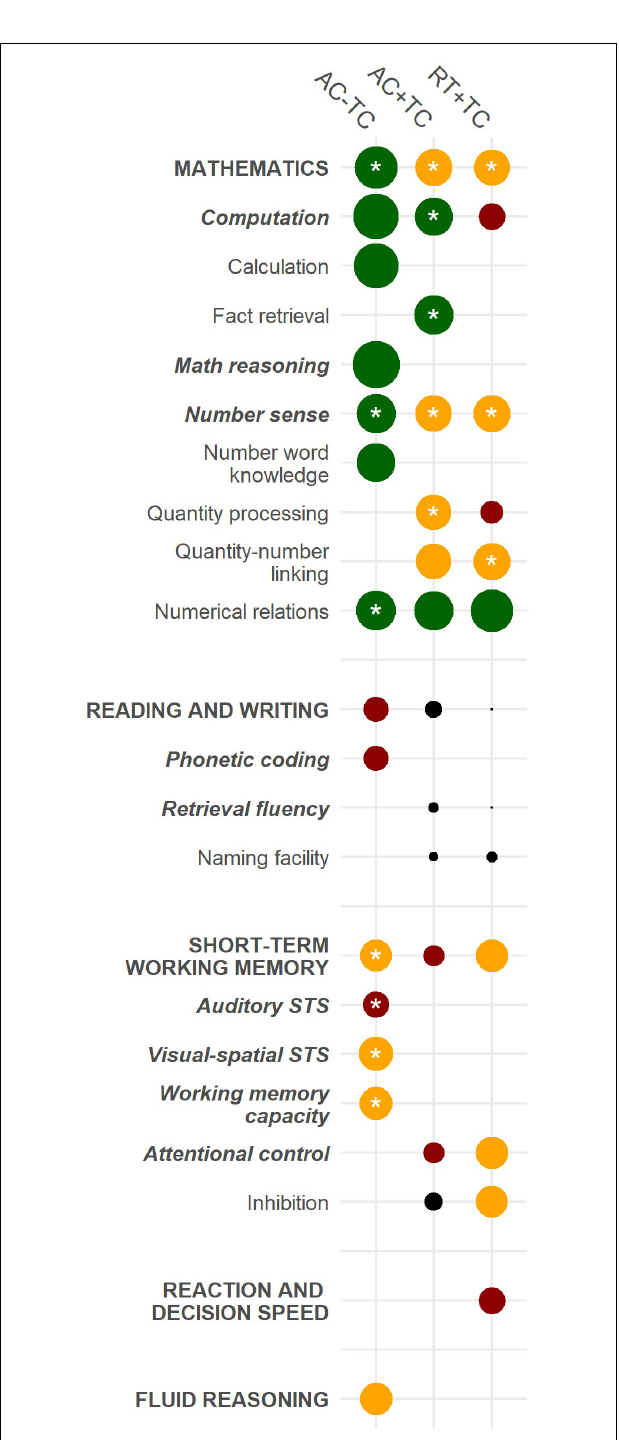
FIGURE 2 | Estimated effects for domain-specific and domain-general abilities. AC, accuracy; RT, response time; TC, time constraints; STS, short-term memory; font formatting reflects ability level (high-level ability, bold and uppercase; medium-level ability, bold and italic; low-level ability, no formatting); size of circle reflects size of effect (i.e., the larger the circle the larger the effect in favor of TD); color of circle reflects type of effect (green = large, yellow = medium, red = small, black = none); *significant effect